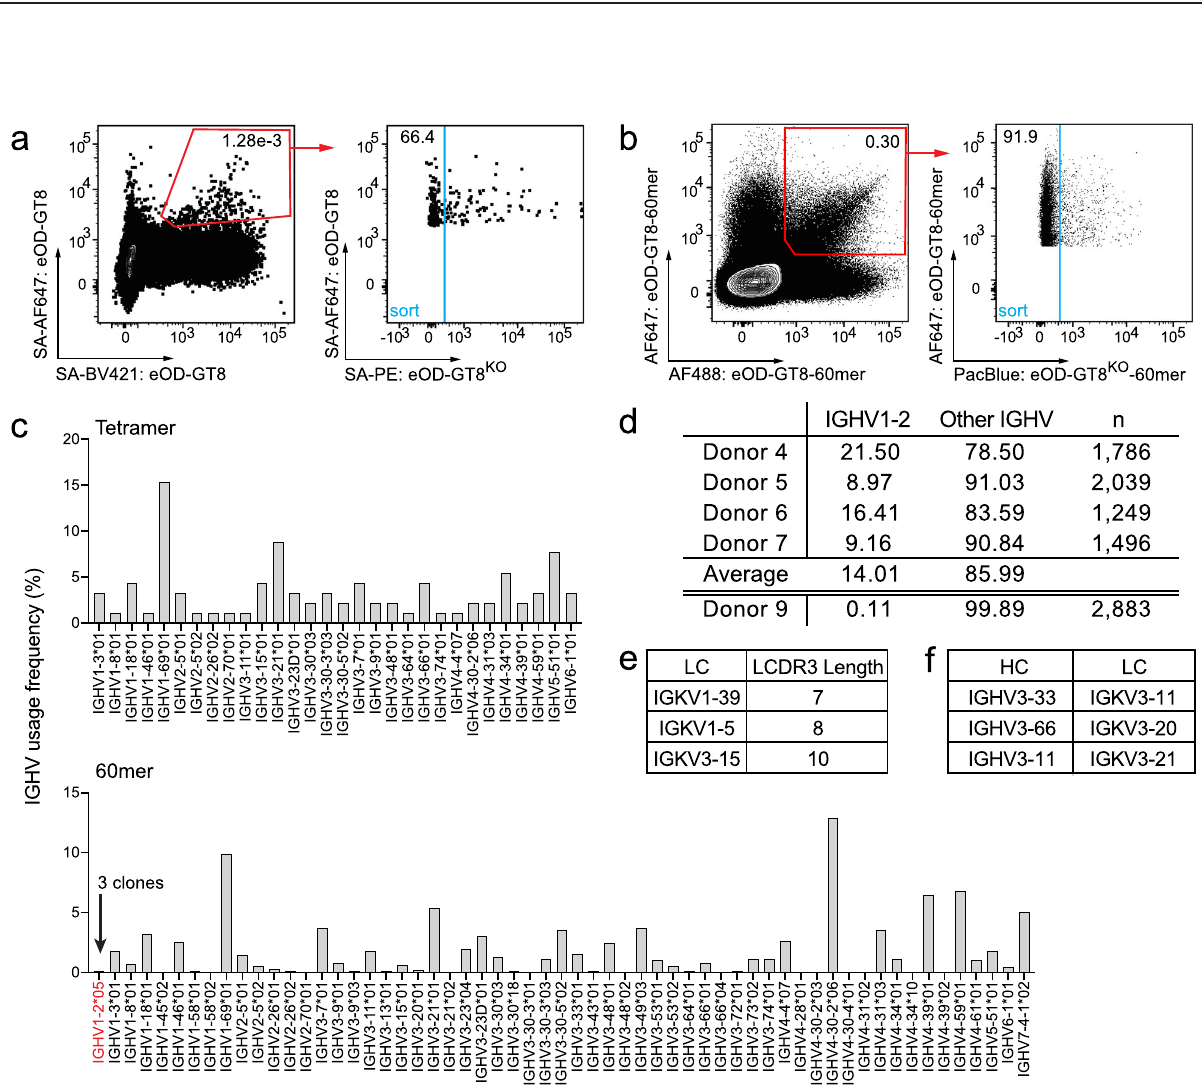
Fig. 3 Some individuals do not have VRC01-class naive B cells due to incompatible IGHV1-2 alleles. B cells were enriched from donor 9 PBMCs, stained with eOD-GT8 tetramer or eOD-GT8 60mer probe set, and sorted for IgG neg /eOD-GT8 ++ eOD-GT8 KOneg B cells. a - b Flow cytometry of IgG neg /eOD-GT8 ++ eOD-GT8 KOneg cells using tetramer probes ( a ) or with ( b) 60mer probes. Cells in the blue gate were sorted. c IGHV gene usage among paired BCR sequences derived from tetramer (upper, n = 91) and 60mer (lower, n = 2856) sorted cells. d Frequency of IGHV1-2 BCRs observed in eOD-GT8-60mer-sorted datasets in this study. e Characteristics of LCs paired to the three IGHV1- 2*05 clones detected from 60mer-sorted cells. f Three 5-AA LCDR3 harboring sequences were found among 60mer-sorted cells from donor 9. None of the paired HCs were